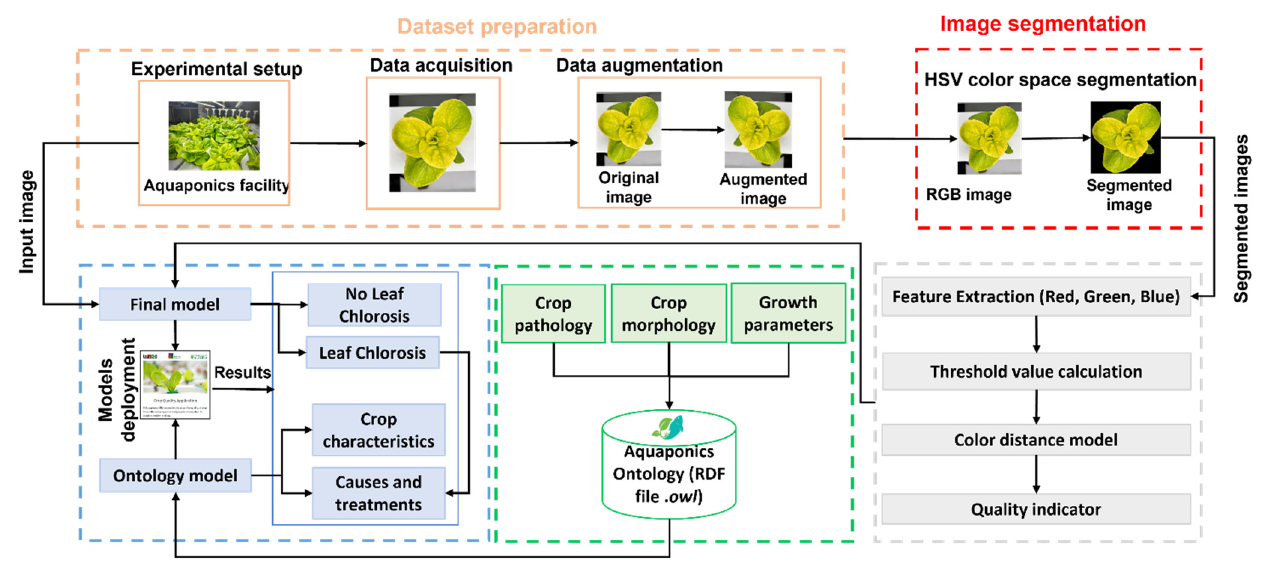
Figure 1. Research methodology outline.